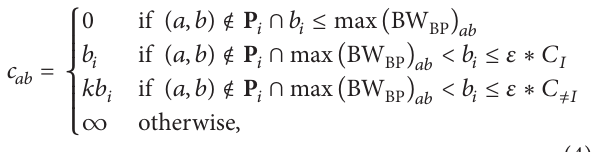
Algorithm 1. Given a directed graph G(E,V) and a source destination pair ( 𝑠, 𝑑 ).